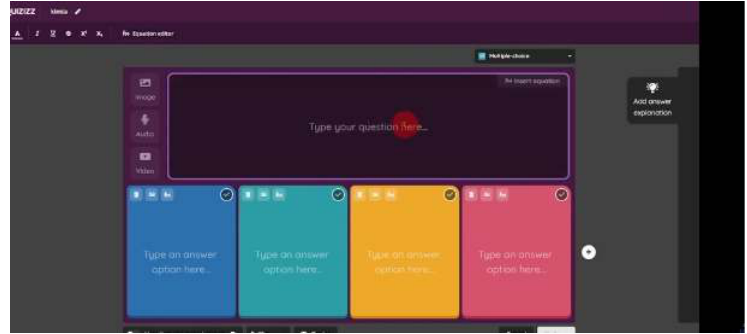
Figure 1. One certain feature of Quizizz (Source: